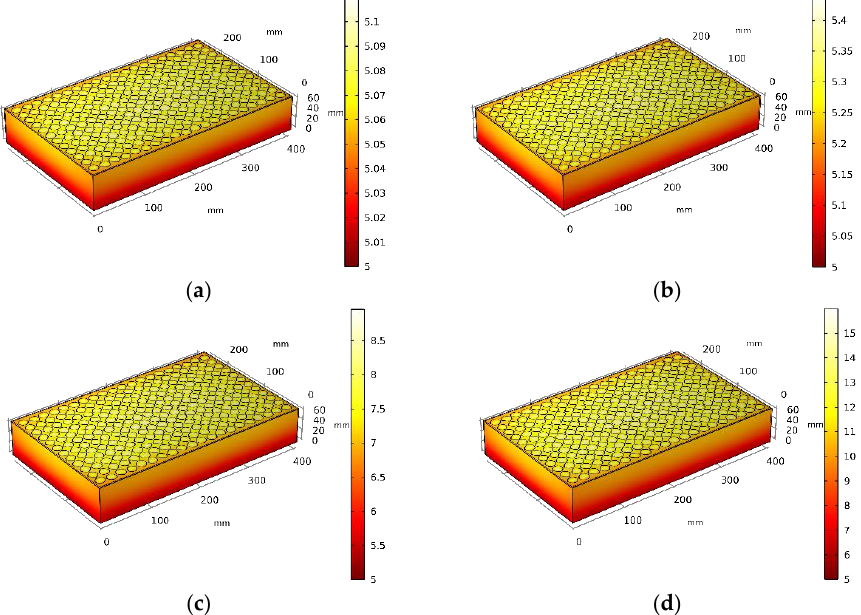
Figure 4. Temperature contours of the entire battery pack in Al housing with different C rates ( a ) 0.5C ( b ) 1C ( c ) 3C ( d ) 5C while ambient temperature of 5 °C is